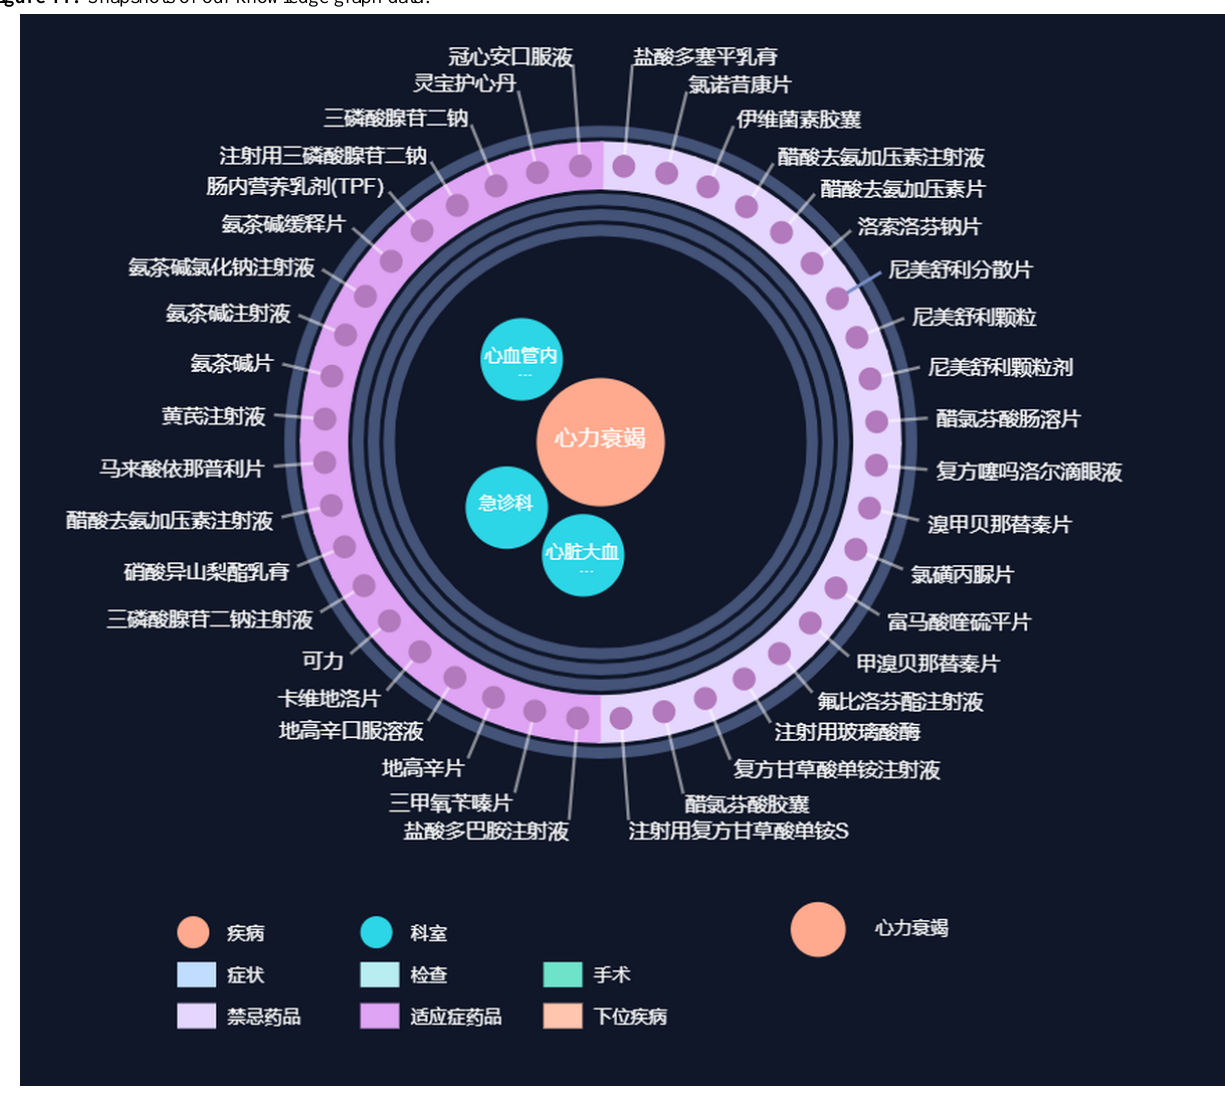
Figure 11. Snapshots of our knowledge graph